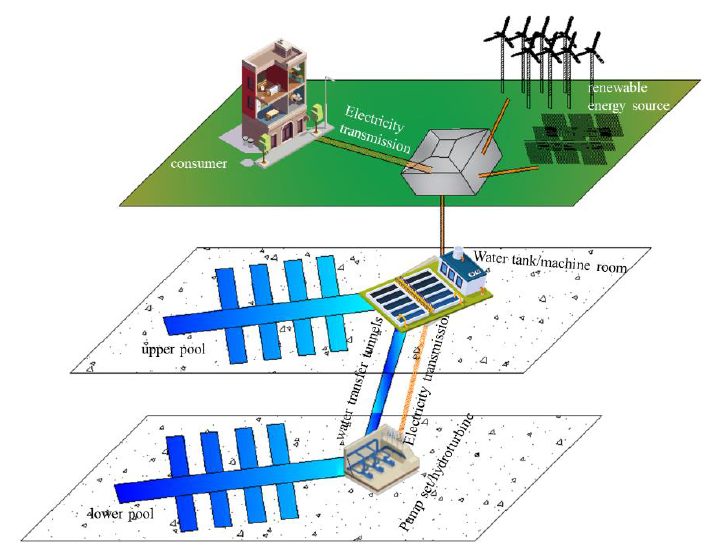
Figure 5. PHS plants system using abandoned mines.